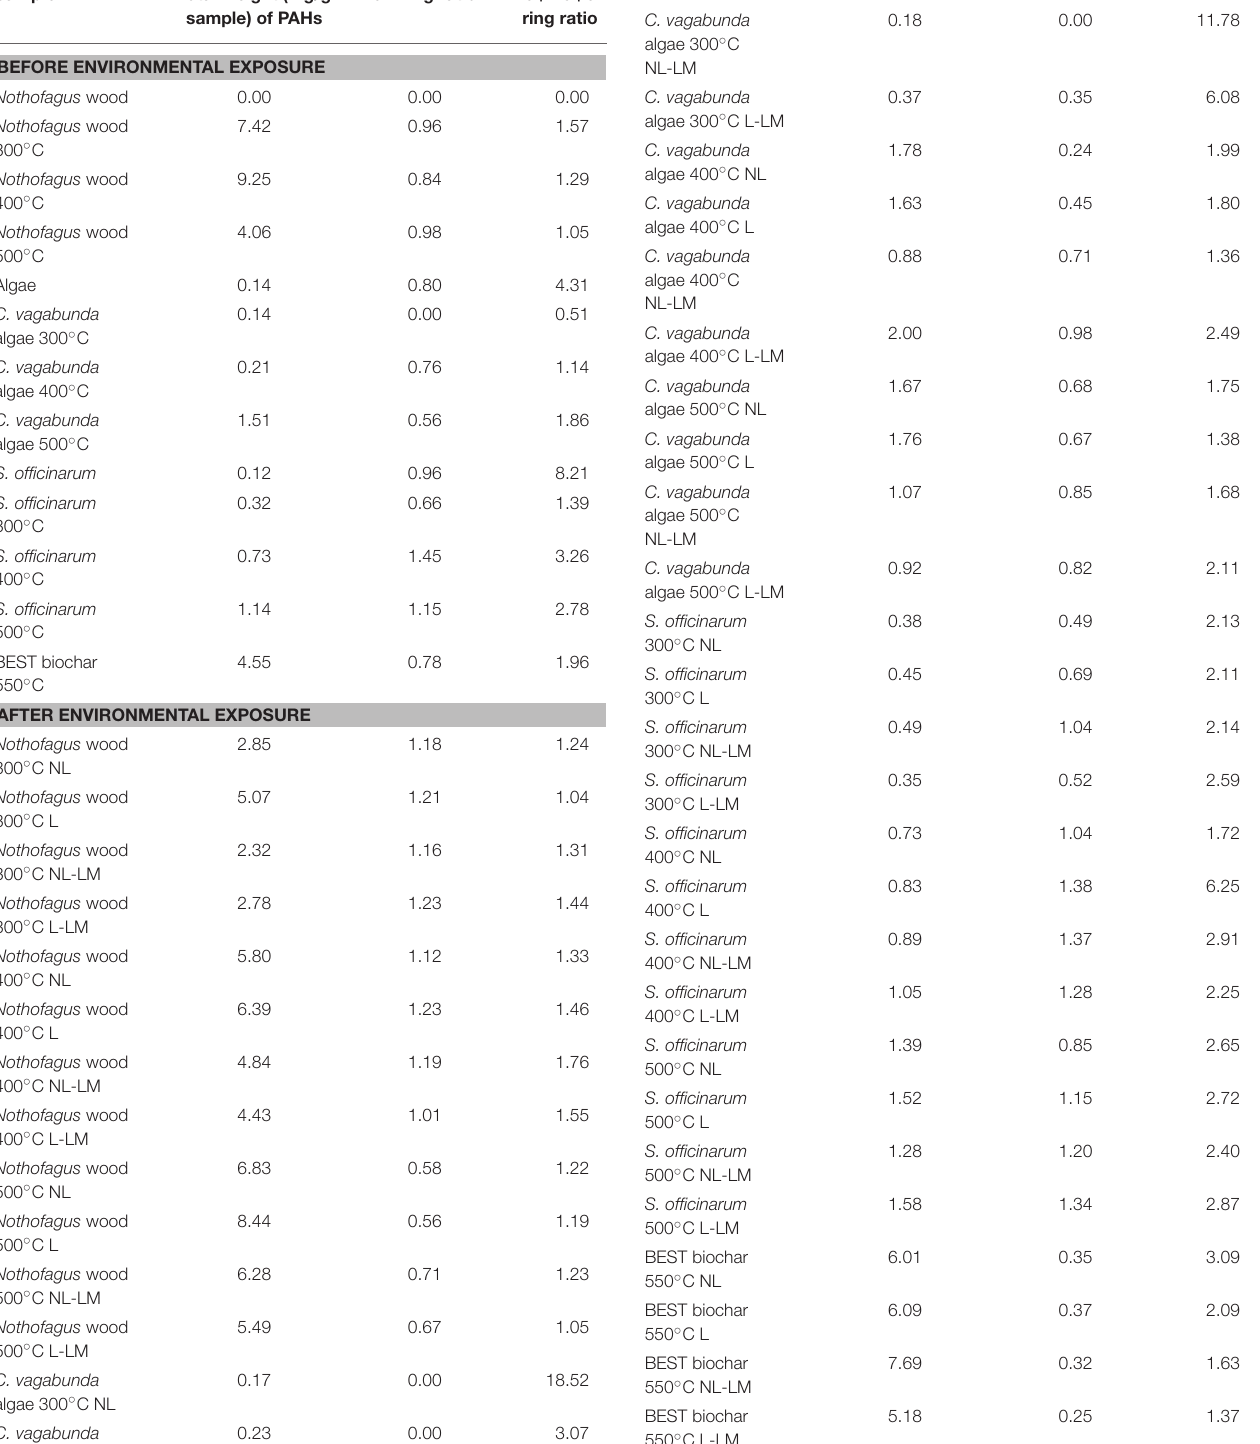
TABLE 3 | The total weight (mg/g sample), 3:4 ring ratio and 3 + 4:5 + 6 ring ratio of extractable low molecular weight polycyclic aromatic hydrocarbons before and after environmental